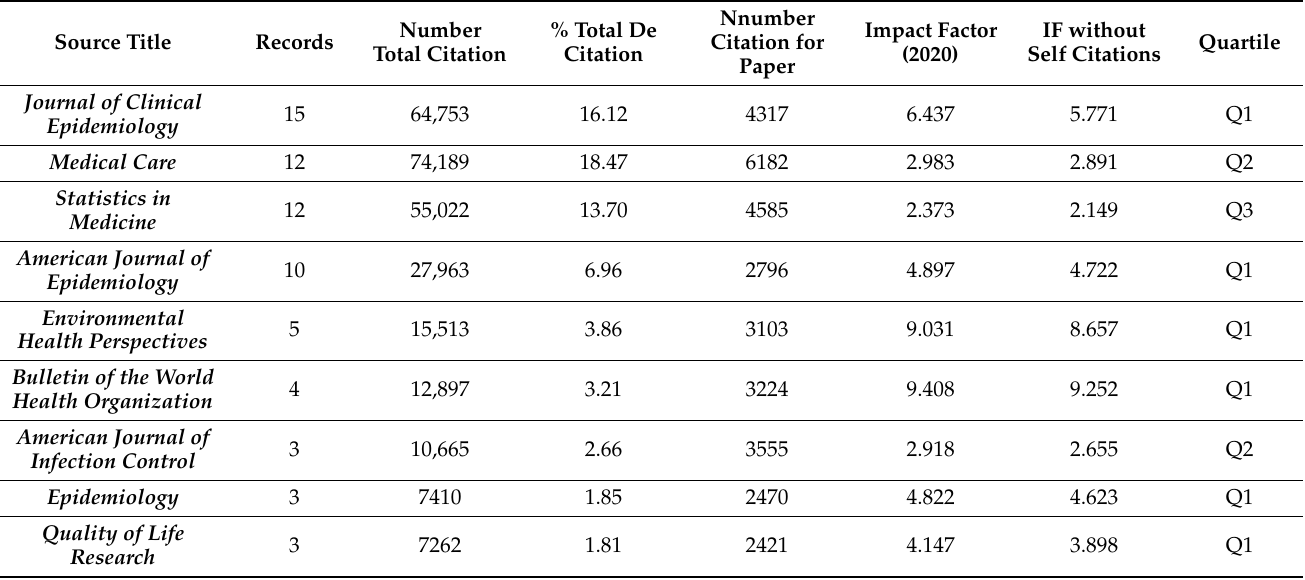
Table 5. The top journals that published the top 100 highly cited literature in Public, Environmental & Occupacional Health